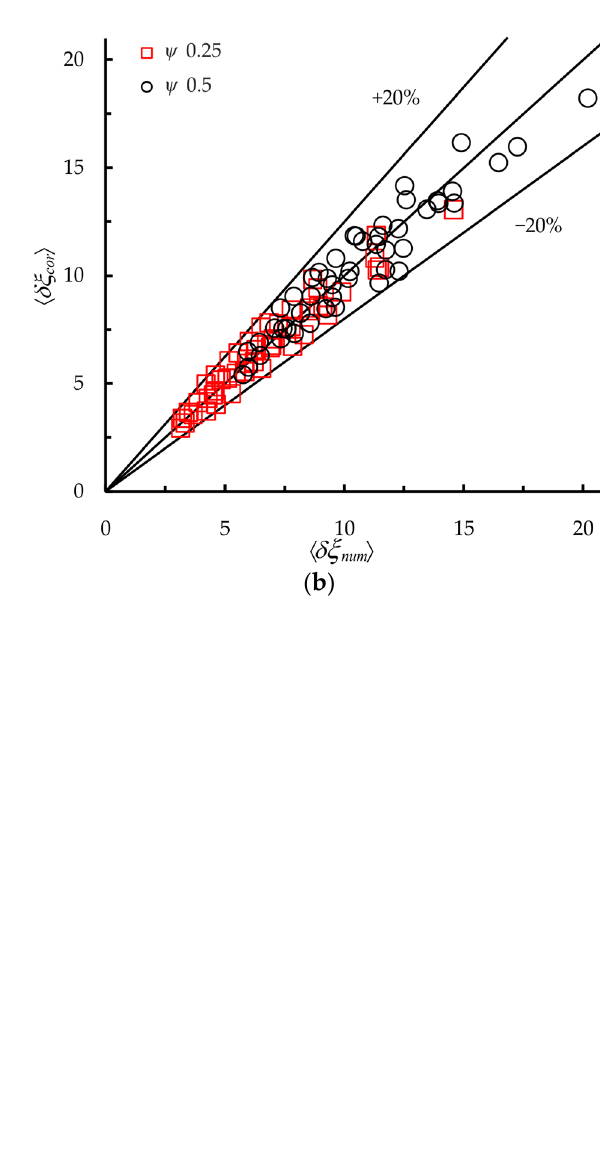
Figure 19. Comparison between correlations (13)–(18) and numerical simulation: ( a ) the Nusselt number ratio. ( b ) The friction factor ratio. ( c ) TPE.